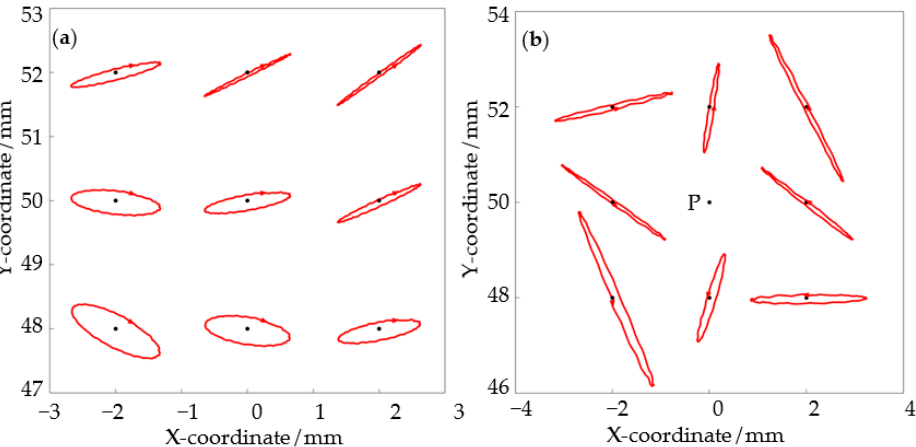
Figure 16. ( a ) The absolute trajectories of molten particles with u y magnified 10 times, and ( b ) the relative trajectories to the center magnified 40 times in the steady wave field.